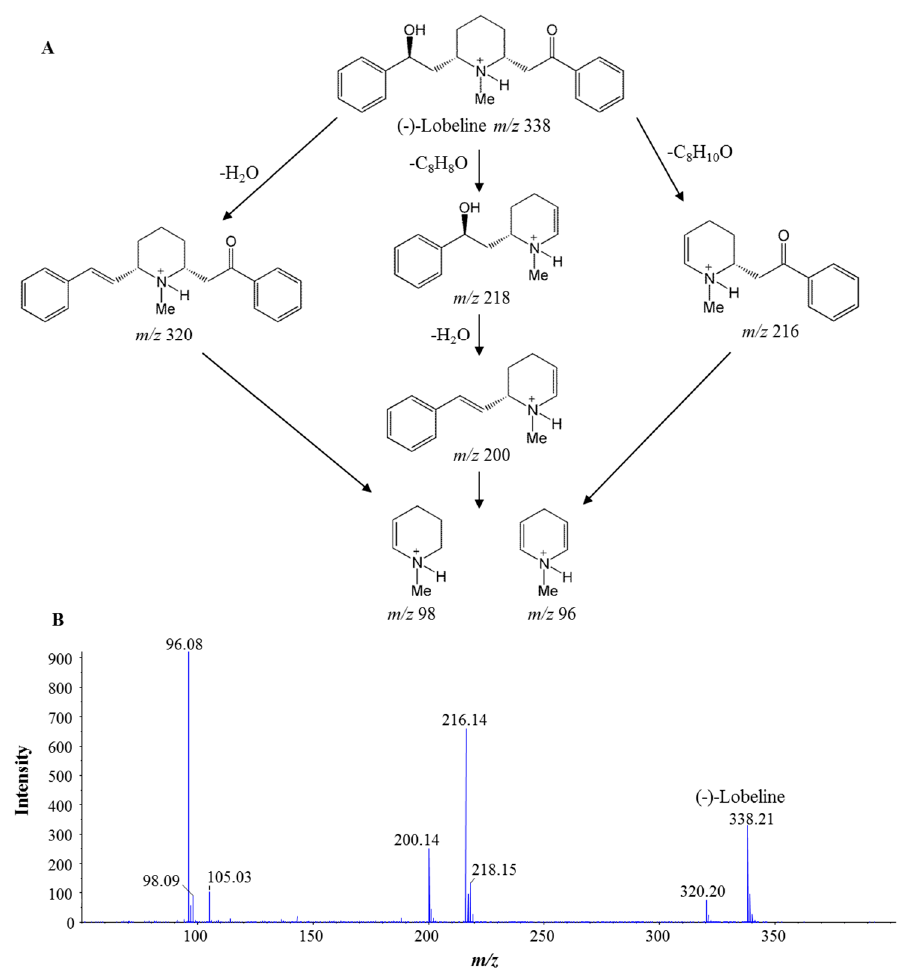
Figure 5. The fragmentation rules ( A ) and tandem mass spectrometry (MS/MS) spectrum ( B ) of lobeline.